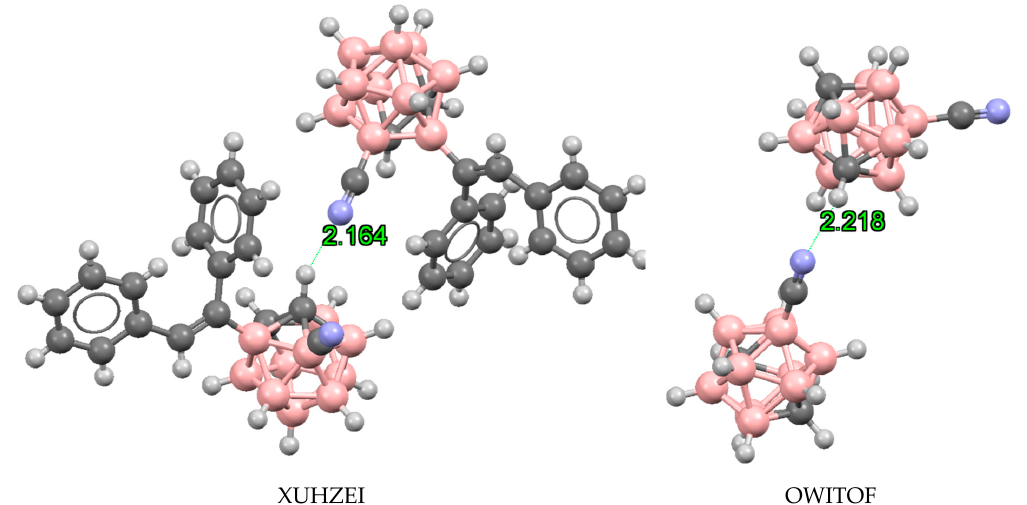
Figure 7. Structures retrieved from the CSD database with an indication of the N···H intermolecular distances. The Refcode of the crystal structure is indicated.